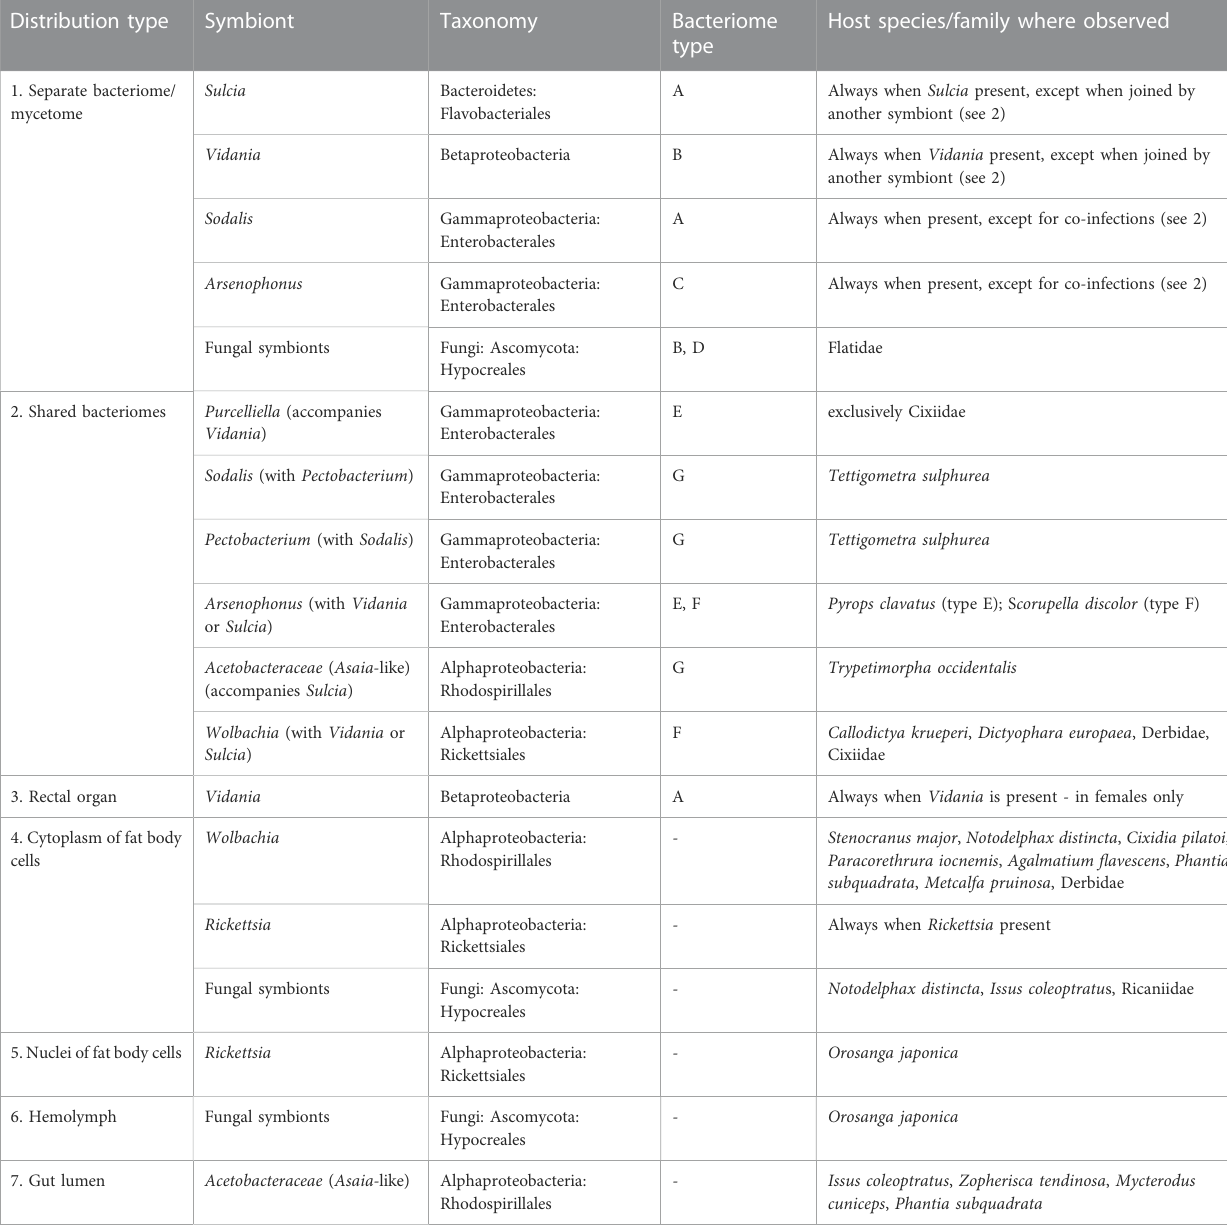
TABLE 1 Symbiont tissue localizations and bacteriome types identi fi ed among the surveyed planthoppers. Distribution